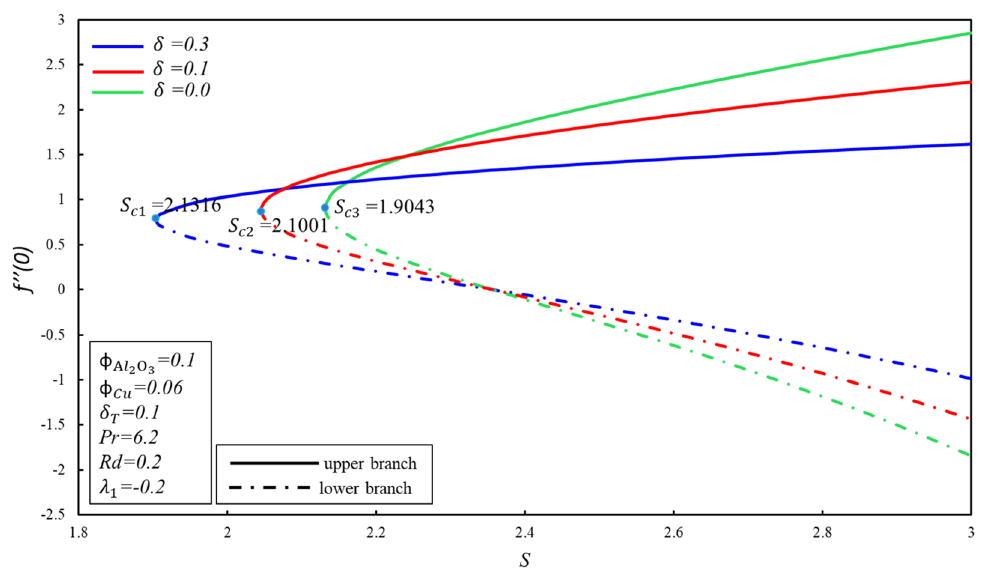
θ ′ ( 0 ) in impact of φ Cu . −